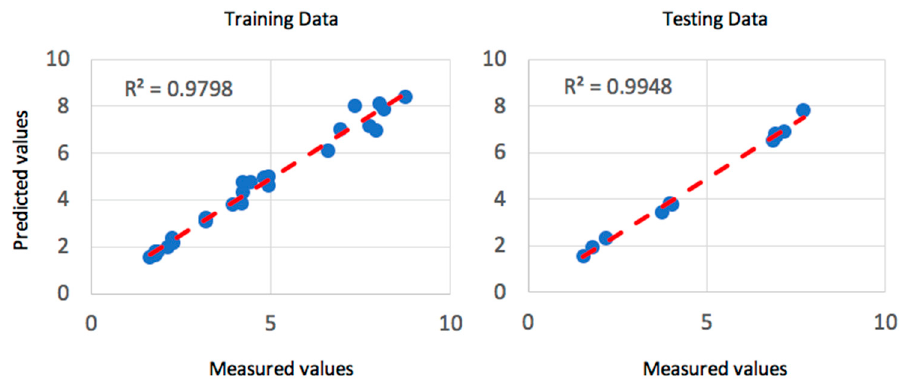
Figure6. Coe ffi cientofdeterminationofR 2 Figure 6. Coefficient of determination of R 2 for the training and testing dataset of the dry turning process.